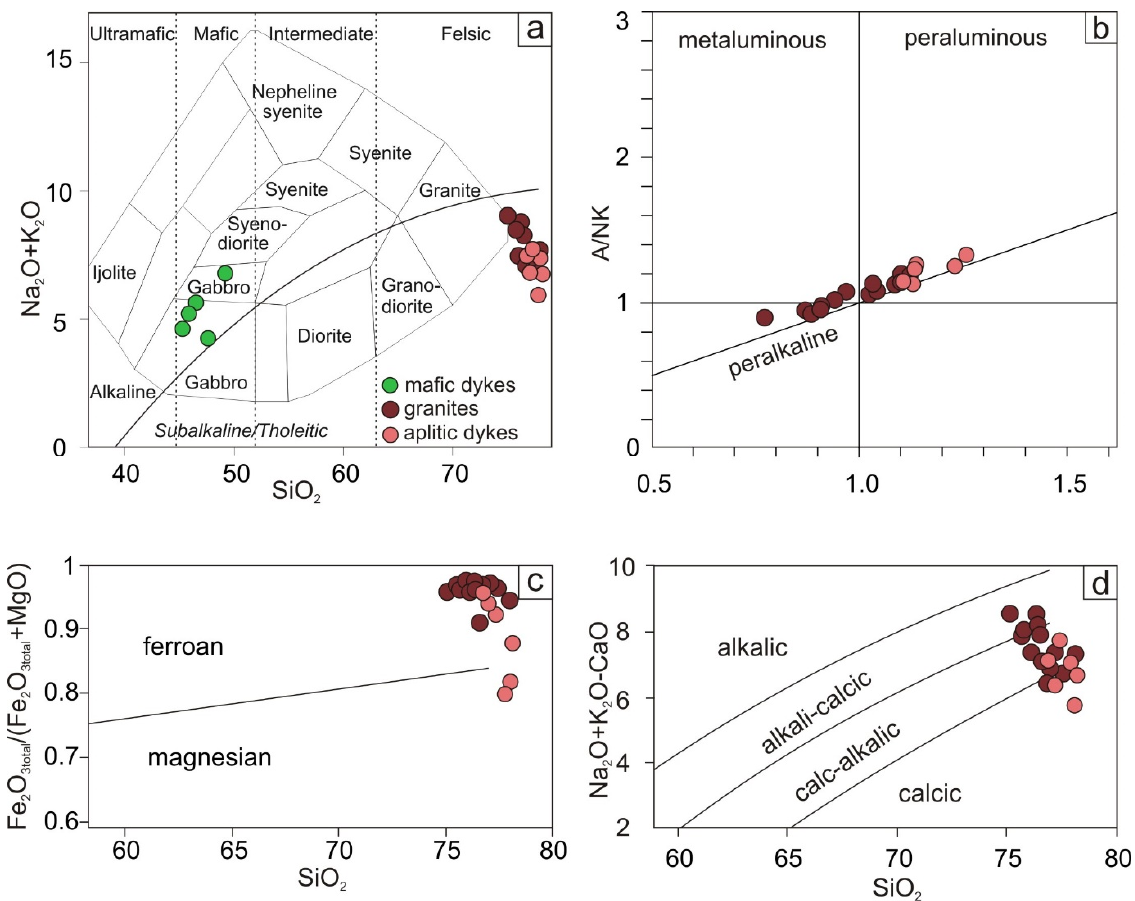
Figure 6. ( a ) TAS diagram (fields according to [41]); ( b ) Al 2 O 3 /(CaO + Na 2 O + K 2 O)–Al 2 O 3 /(Na 2 O